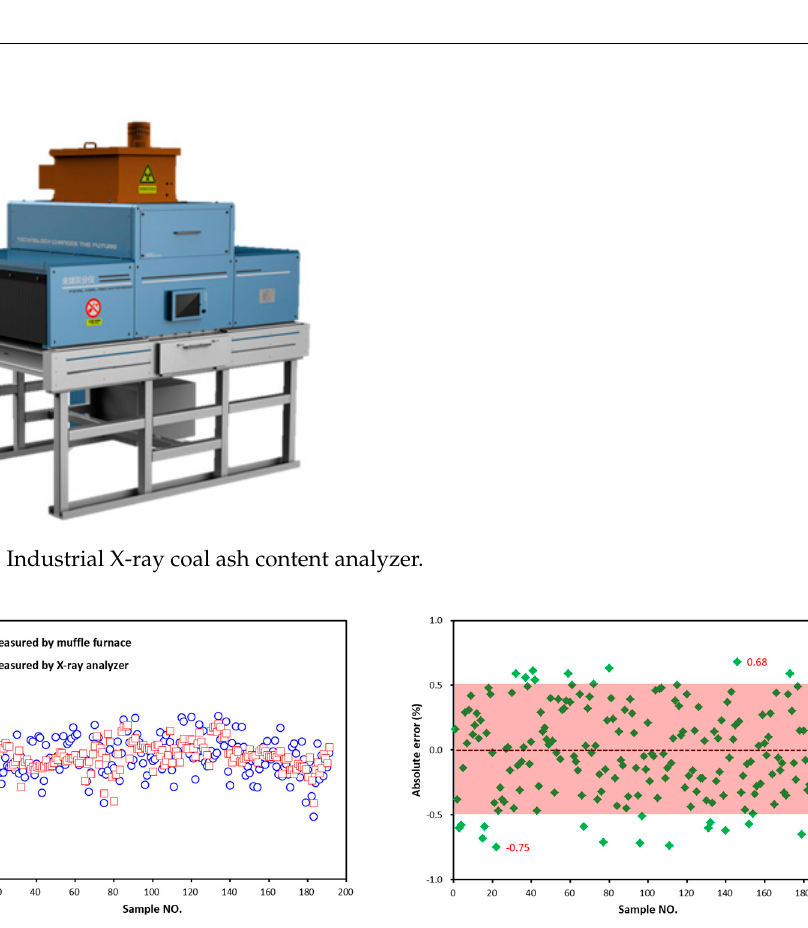
Figure 9. The difference ( left ) and absolute error ( right ) between the ash contents measured by the muffle furnace and the